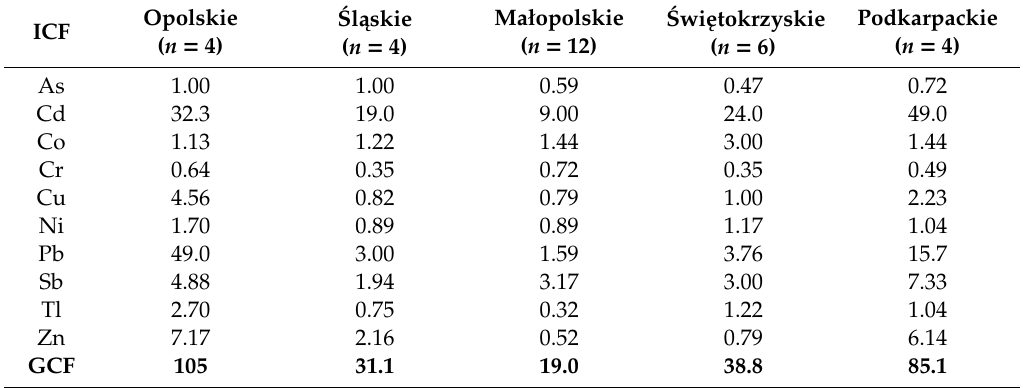
Table 7. Potential adverse e ff ect risks, according to the individual contamination factor (ICE) and global contamination factor (GCF)